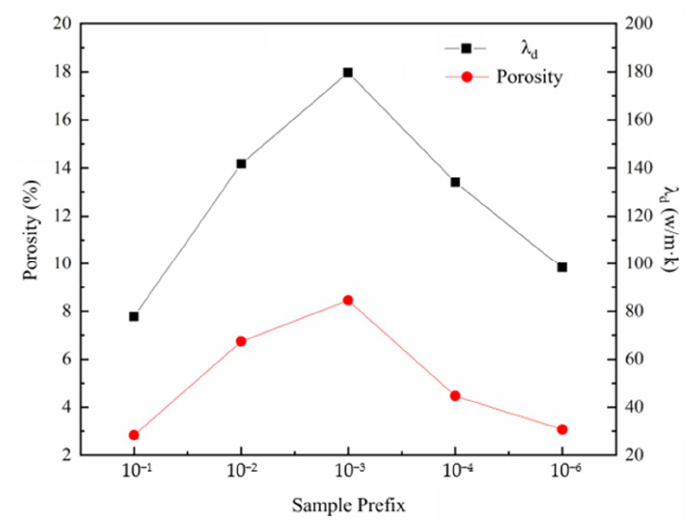
Figure 12. The porosity of each composite and its corresponding λ d value.